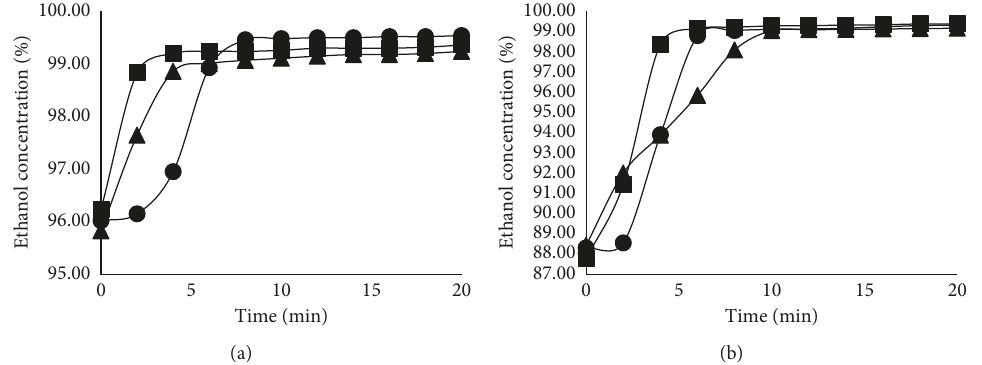
Figure 6: Ethanol concentration vs. time for various adsorbents at the different temperatures and initial water concentration. (a) 96% ethanol initial concentration for PVA/Zeo/AC 1:1 :1; (b) 88% ethanol initial concentration for PVA/Zeo/AC 1:1:1. , 22 ° C; ■ , 30 ° C; , 40 ° C.